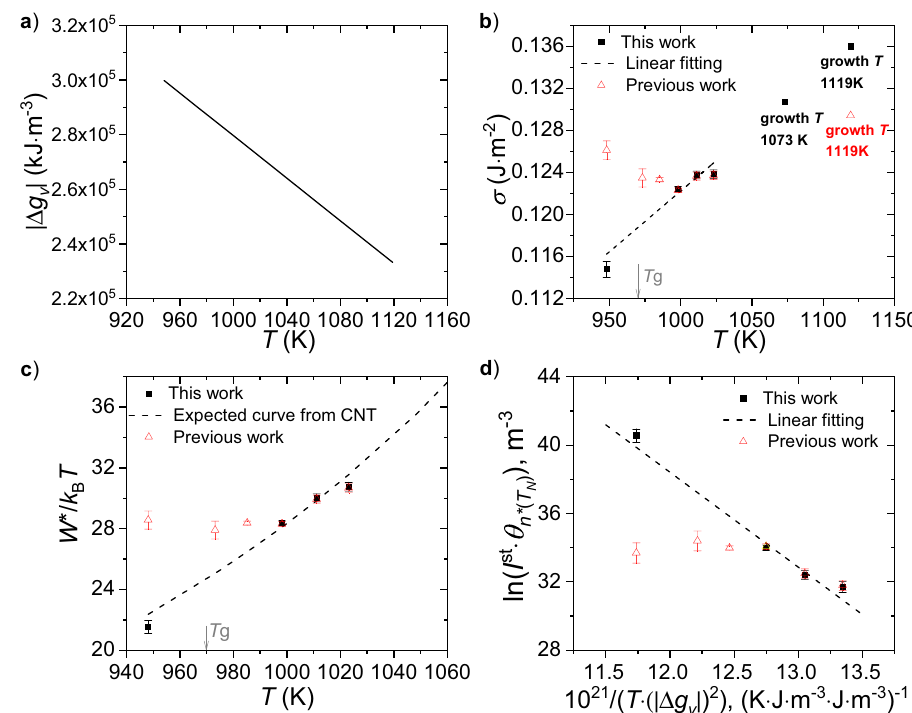
Fig. 3 The values of nucleation parameters obtained from this study and from the previous study 10 . This study uses the longer nucleation time at 948 K, and the previous study 10 used shorter-time nucleation data at low temperatures for 5BaO ∙ 8SiO 2 glasses. a The driving free energy used as a function of temperature. b The interfacial free energy obtained as a function of temperature. c The scaled nucleation barrier obtained as a function of temperature. d The natural logarithm of the product of the steady-state nucleation rate and the induction time for the critical size at the nucleation temperature, as a function of the reciprocal of the product between temperature and the square of driving free energy. The errors were calculated using the 95% con fi dence intervals of the steady-state nucleation rate and the induction time. The red symbols represent the values obtained in the previous study 10 (reproduced from ref. 10 with permission from Elsevier). T g is the glass transition